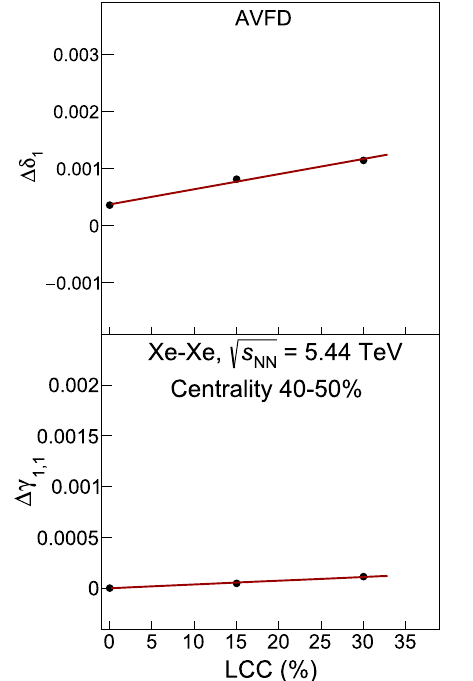
Fig. 7 The dependence of (cid:9)δ 1 and (cid:9)γ 1 , 1 in the upper and lower pan- els, respectively, on the percentage of local charge conservation in the √ s NN = 5 . 02 TeV for the analysed samples of Xe–Xe collisions at 40–50% centrality interval (cid:9)γ = e · ( n / s ) 2 + e · ( n / s ) + d · ( LCC ) + d 1 , 1 2 1 1 5 5